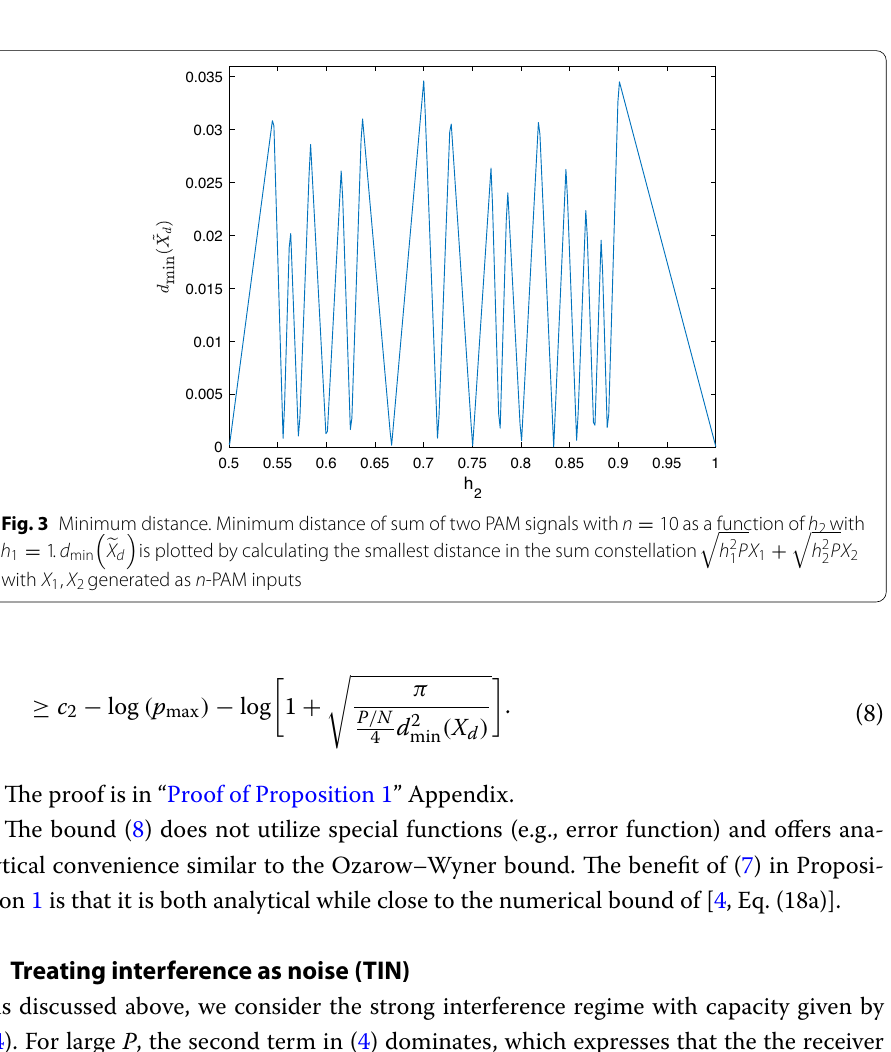
Fig. 3 Minimum distance. Minimum distance of sum of two PAM signals with n h 1 1 . d min is plotted by calculating the smallest distance in the sum constellation h 2 2 PX 2 = with X 1 , X 2 generated as n ‑PAM